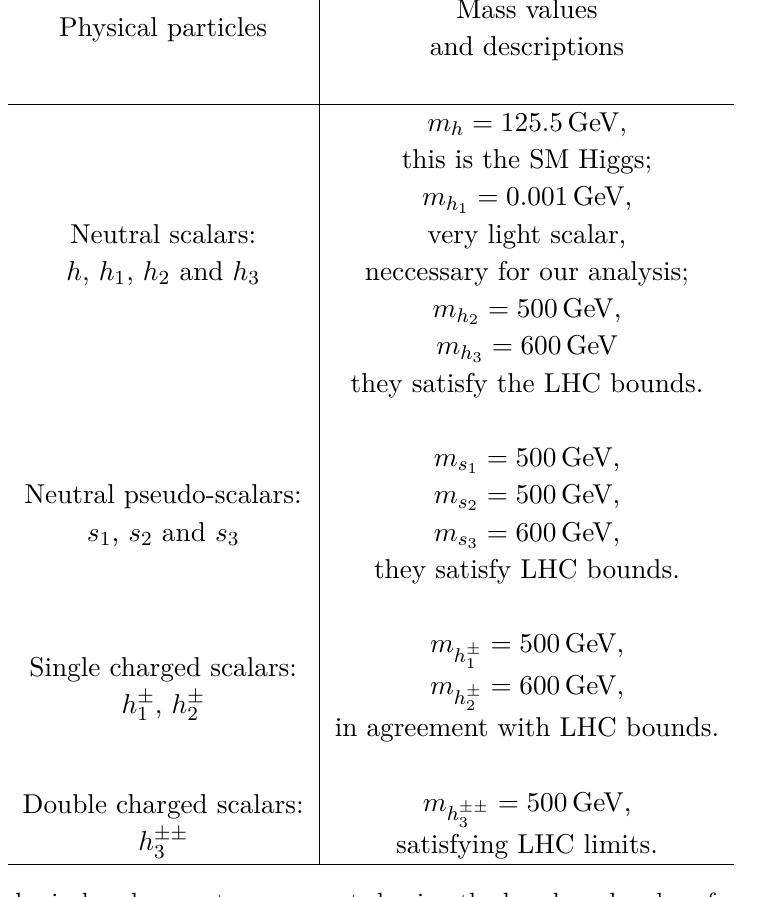
is the light scalar which will be 1